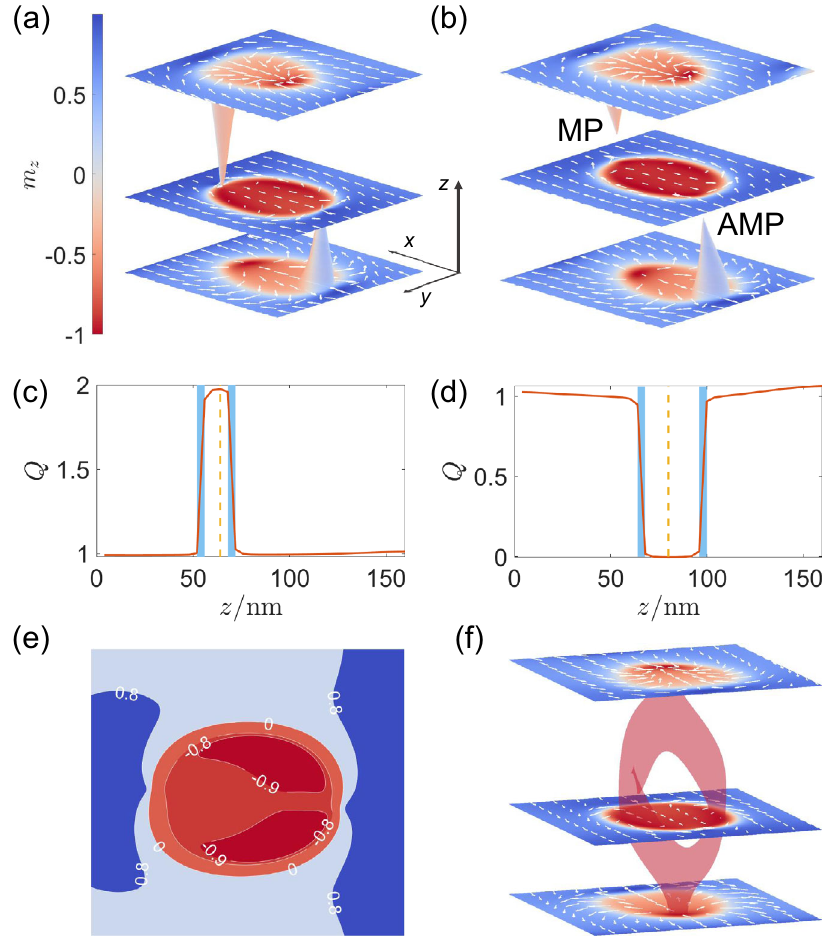
Fig. 3 3D structures of the biskyrmion and the bubble. a , b 3D magnetization structures of the biskyrmion in Fig. 2a and the bubble in Fig. 2b, respectively. The middle slice demonstrates the spin textures in Fig. 2a and b. The top and bottom slices demonstrate the spin textures in sample surfaces. The cones represent the contour surfaces with m x = − 0.9. c , d The dependence of the topological charge Q on the perpendicular position z of the biskyrmion in Fig. 2a and the bubble in Fig. 2b, respectively. Q is calculated with each spin layer along the z - axis. The perpendicular positions of slices in Fig. 2a and b are indicated by orange dashed lines. e Contour lines of m z of the biskyrmion in Fig. 2a. f The contour surface with m z = − 0.96 of the 3D structure of the biskyrmion in Fig. 2a. The 3D magnetization structures are extracted from the fi lm displayed in Supplementary Fig.